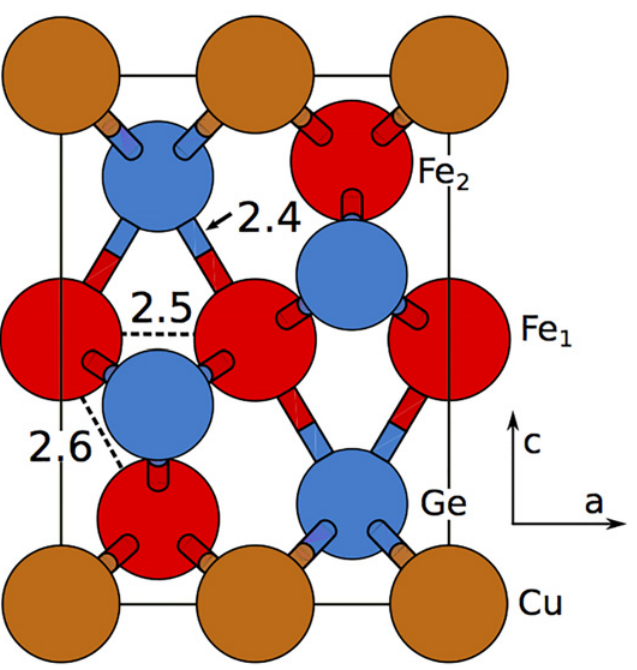
Fig 2. The projection of CuFe 2 Ge 2 unitcell on to ac plane. Fe 1 (middle layer) are octahedrally coordinated. The atomic distances are marked in